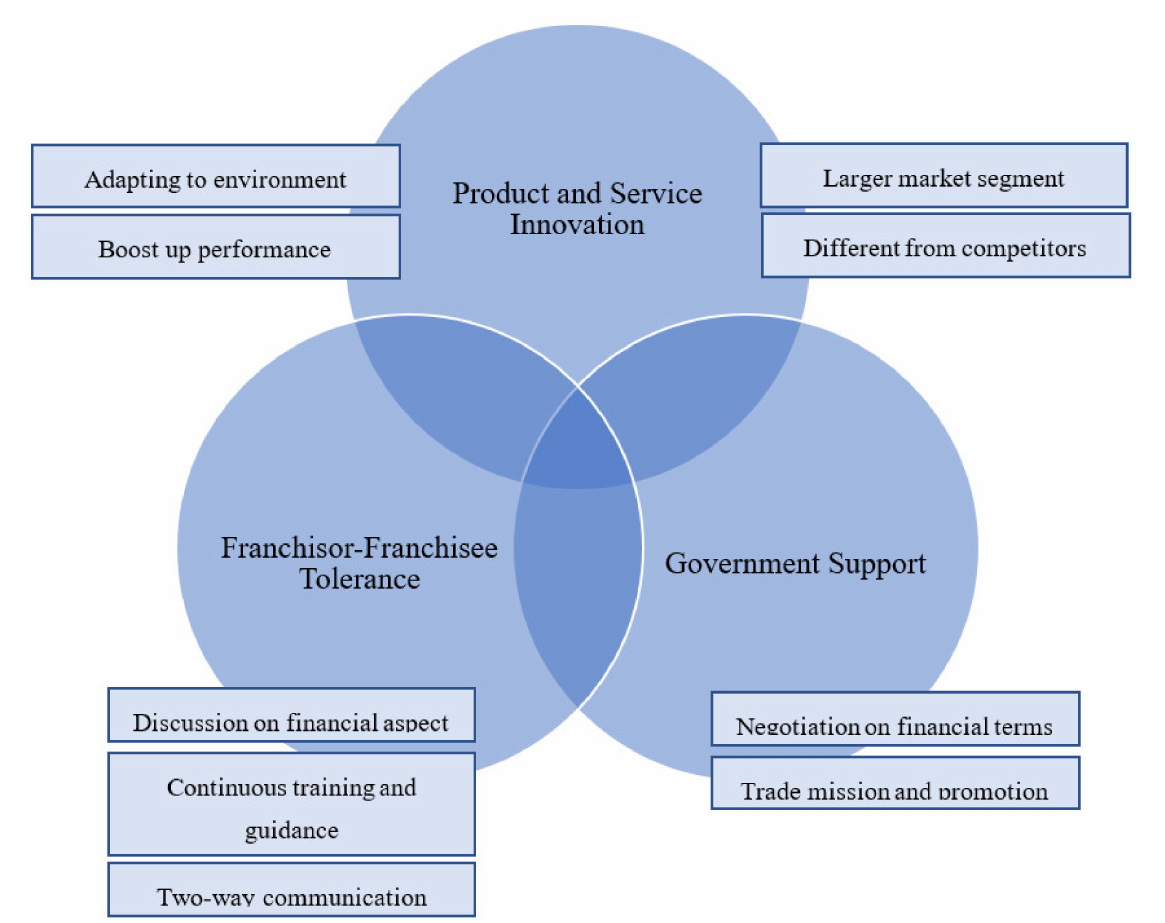
Figure 3. Framework for the Growth of Franchisor and